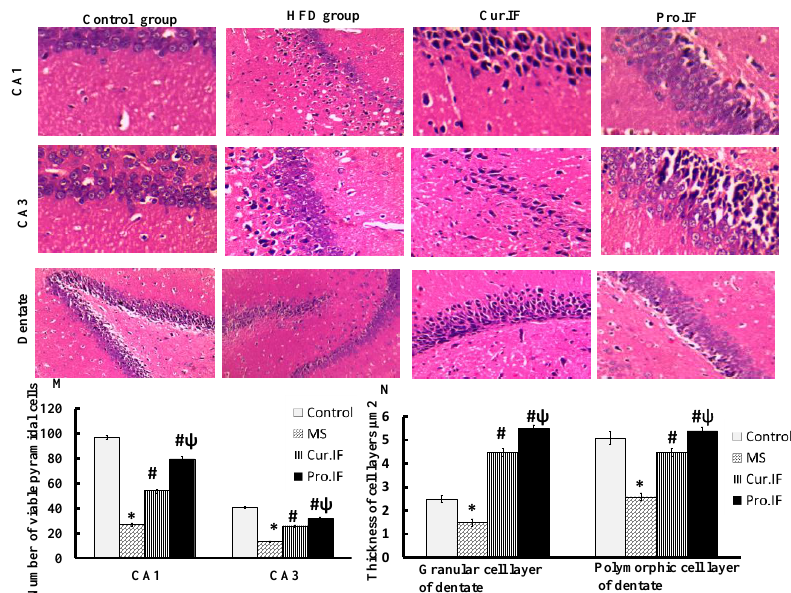
Figure 6. Effect of HFD and/or pro. and cur. IF on hippocampal structure. The figure showed normal morphology of CA1, CA3 and dentate gyrus in the control group with normal viable pyramidal cells, granular cells, absent apoptosis and normal blood vessels. The HFD group showed scattered degenerations, decrease in the viable pyramidal cells in both CA1 and CA3 areas of the hippocampus ( M ) together with decrease in the thickness of granular cells in dentate gyrus ( N ). The cur. IF group showed multiple degenerated cells, mild apoptosis while pro.IF group showed marked increase in the viable pyramidal cells with scattered degeneration in CA1 and CA3 regions dentate gyrus showed increase in thickness of its layers in both groups. * HFD significant vis. control group, # pro. and cur. IF significant vis. HFD group, ψ pro. IF significant vise cur. IF ( N ). Nutrients 2021 , 13 , x FOR PEER REVIEW